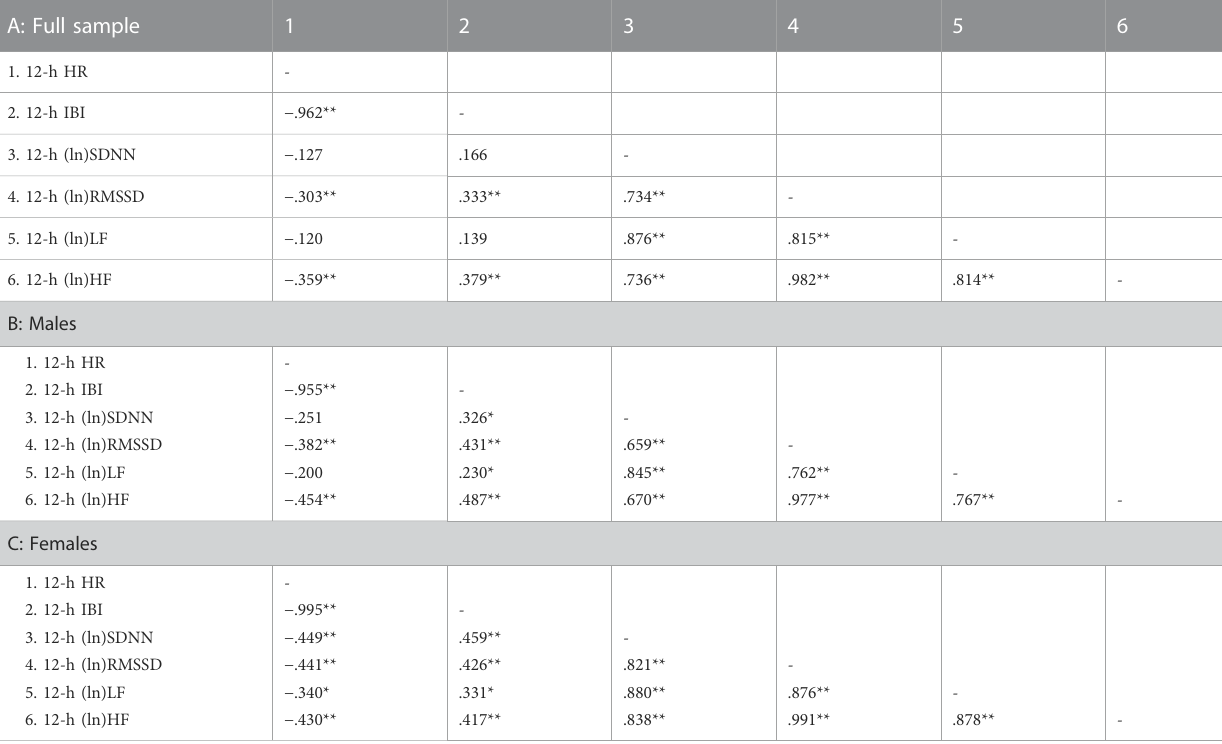
TABLE 3 Correlation coef fi cients in the full sample and strati fi ed by sex for 12-h values of cardiac chronotropy and heart rate variability during the light phase of the daily cycle. A: Full